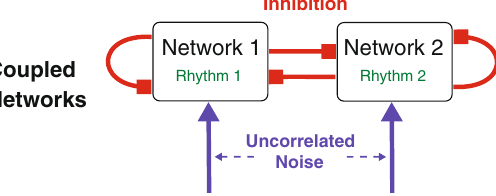
Figure 1. Interacting rhythms in two coupled oscillator networks. Each oscillator receives inhibition from the oscillators in its own network and from the oscillators in the other networks. In addition, each oscillator receives uncorrelated noisy